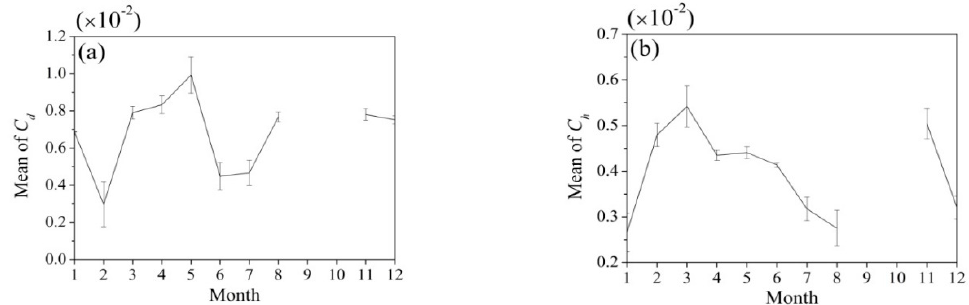
Figure 11. ( a ) Monthly variations in the mean values of C d under NNE–ESE wind direction from 5 January to 31 December 2010. ( b ) Monthly variations in the mean values of C h under NNE–ESE wind direction from 5 January to 31 December 2010.